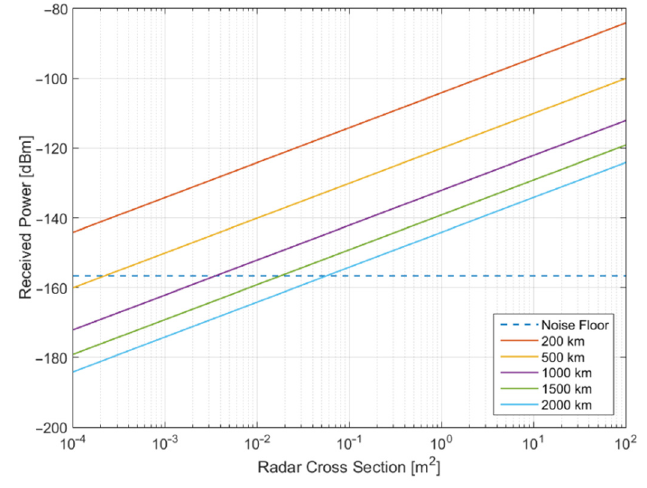
Figure 3. Simulated received power at the antenna (SRT) as a function of the radar cross section (RCS) and range of the object for the Bistatic Radar for Low Earth Orbit (LEO) Tracking (BI- RALET) system.